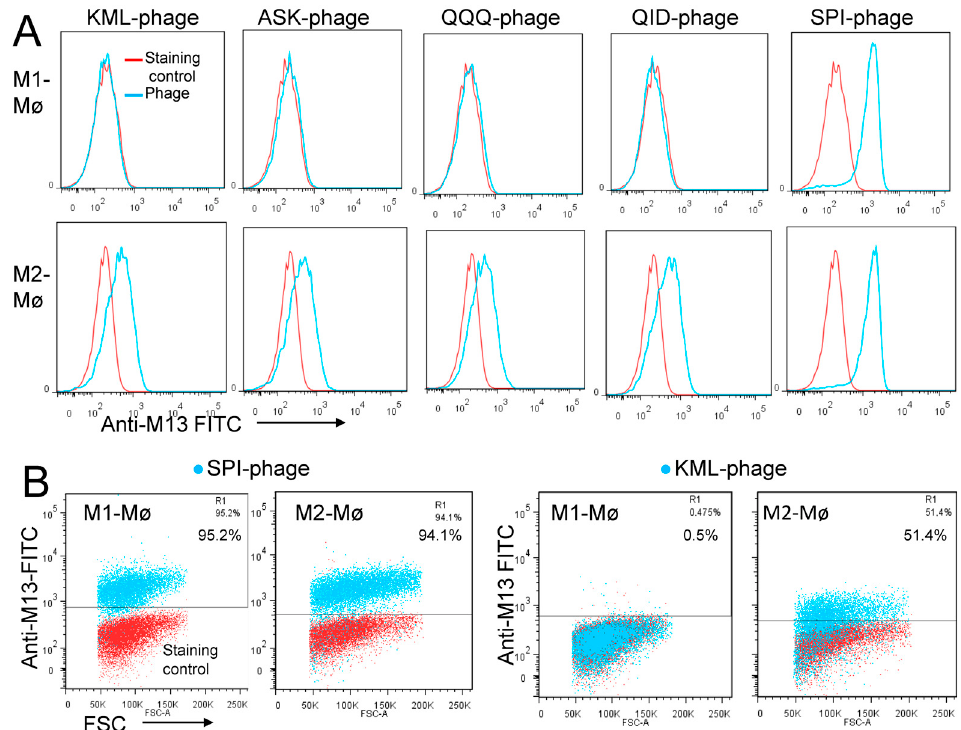
Figure 6. Flow cytometry analysis of the phage binding. ( A ) Representative examples of flow cytometry histograms showing the binding of low affinity phage-displayed peptides to M1 and M2 macrophages. The phage displaying SPI peptide (SPI phage) was included as a positive control that binds to both macrophage subsets. Binding was detected using FITC conjugated an anti-M13 monoclonal antibody. ( B ) To better visualize the percentage of positive cells, the binding of the phage displaying KML peptide (low affinity) and SPI peptide (high affinity) were also presented as dot plots.